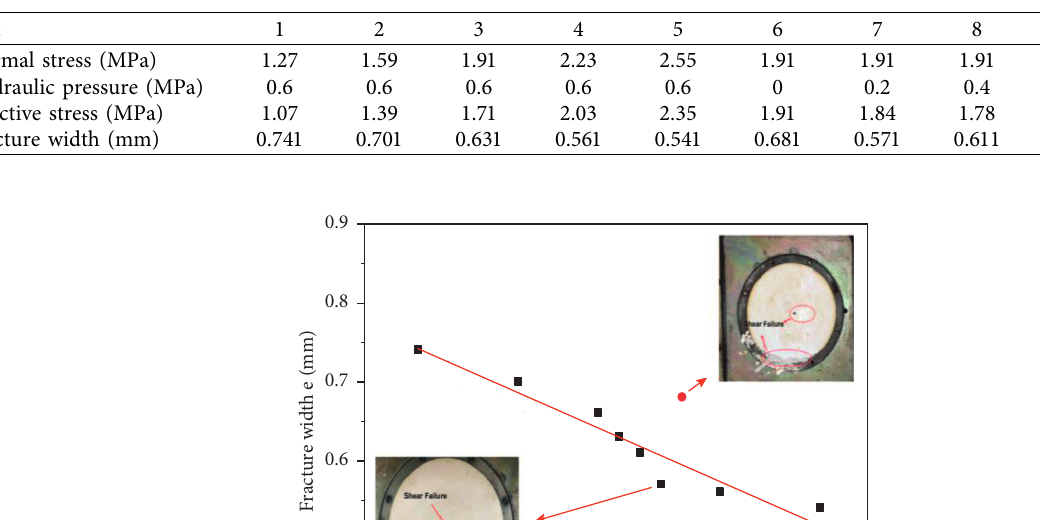
Table 4: Fracture aperture under different working conditions.